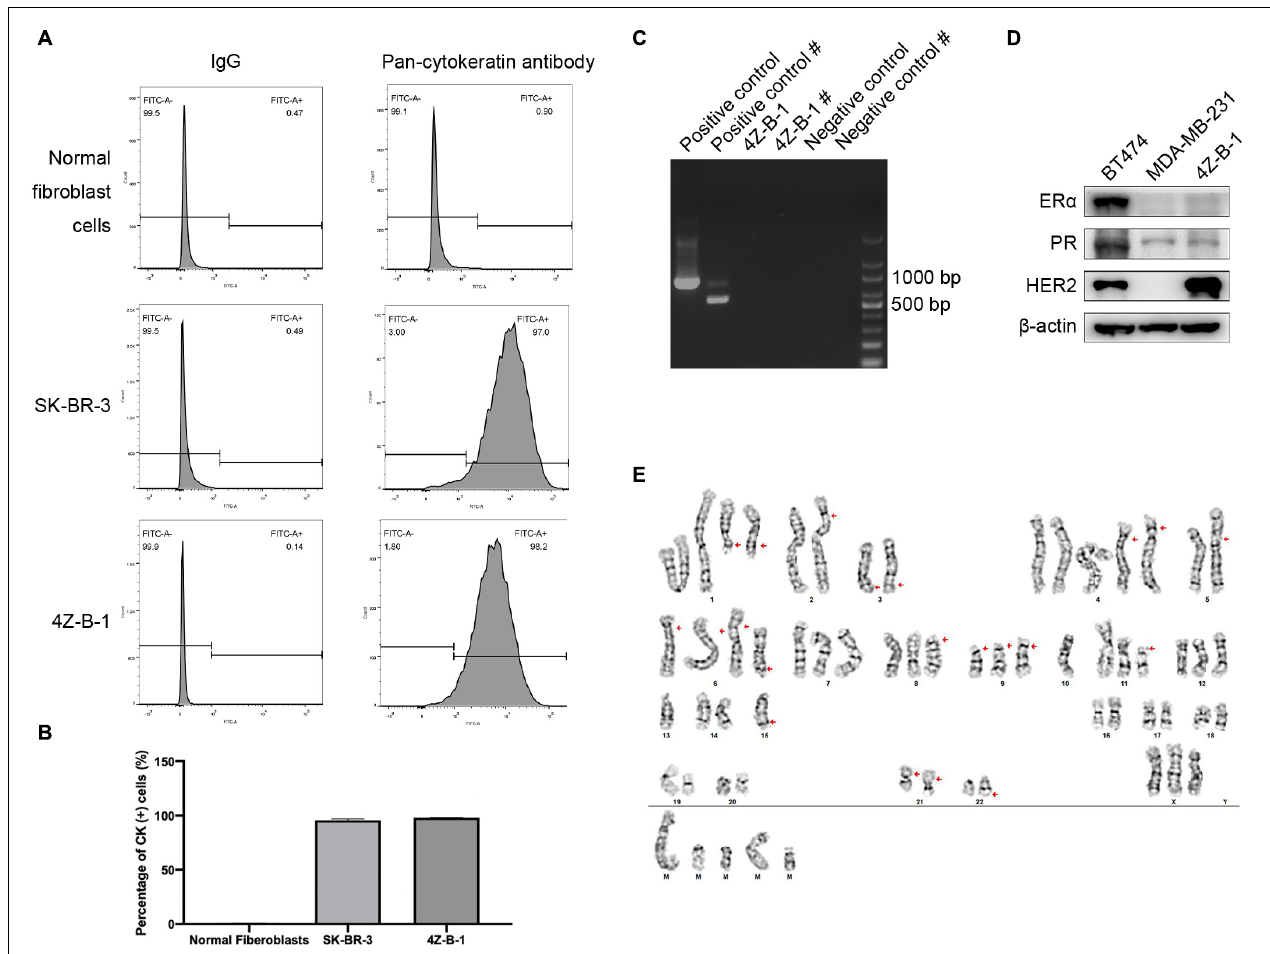
FIGURE 2 | Purity, mycoplasma contamination, molecular subtype and karyotype analysis of 4Z-B-1 (A,B) The purity of the normal fibroblast cells, SK-BR-3 and 4Z-B-1 was evaluated, and the expression of pan-cytokeratin was detected by flow cytometry. (C) 4Z-B-1 was detected free of mycoplasma. # represents the second PCR, which had improved sensitivity and specificity. (D) 4Z-B-1 cells were negative for ER α and PR but positive for HER2. (E) Representative karyotype of 4Z-B-1 cells: 61, XXX; red arrows point to +del(1)(q21) × 2, –2, add(2)(p25), –3, del(3)(q21), +4 × 2, –5, add(5)(p15.3), add(6)(p25) × 3, +del(6)(q23), del(8)(p11.2), del(9)(p12) × 3, –10 × 2, del(11)(p11.2), –13 × 2, –14, –15 × 2, der(15)t(15:?)(q26.1;?), –16, –17, –18, –19, –20, –21, add(21)(p12) × 2, –22, der(22)t(22;?)(q13;?), +mar1, +mar2, +mar3, mar4, and +mar5